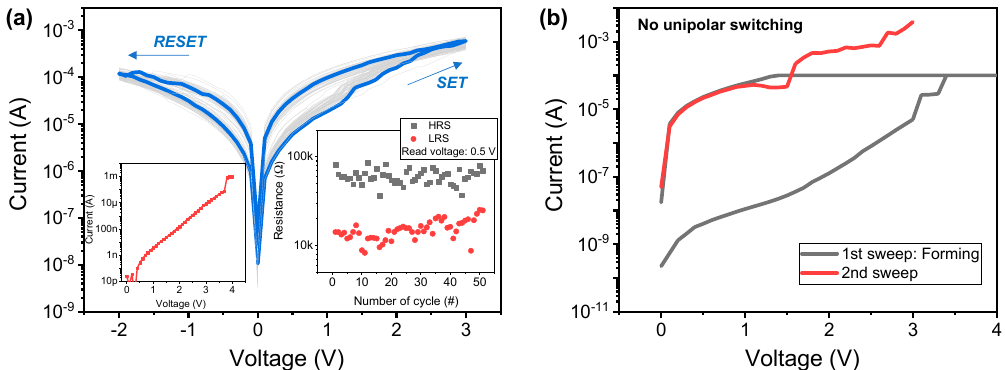
Figure 4. I–V characteristics of Ag / TiO 2 / ZrN / Si device. ( a ) Bipolar resistive switching with gradual SET and RESET processes, forming a curve in the left inset, and endurance cycle in right inset. ( b ) Failure in the working of unipolar switching.